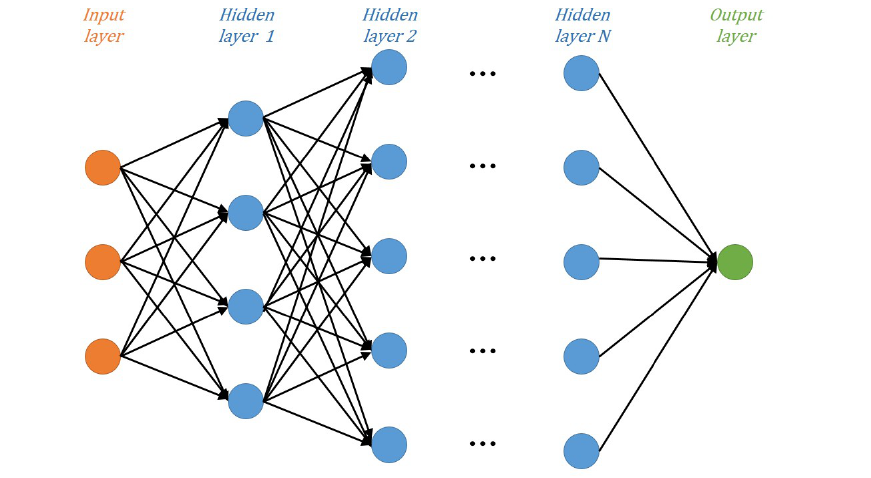
Figure 4. Construction of the deep neural network (DNN)